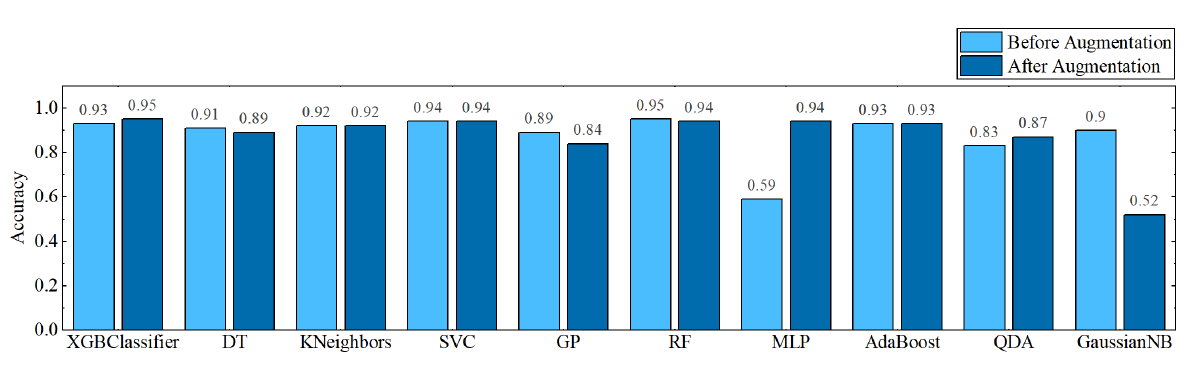
Figure 6. Accuracy results before and after cleaning and